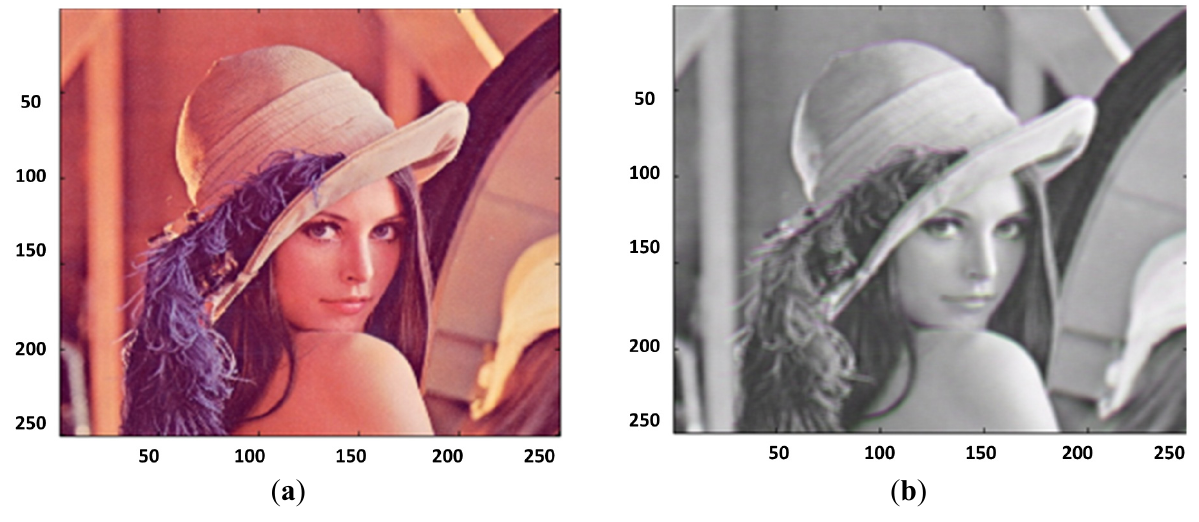
Figure 8. ( a ) Original lena image and ( b ) Lena image after rotor